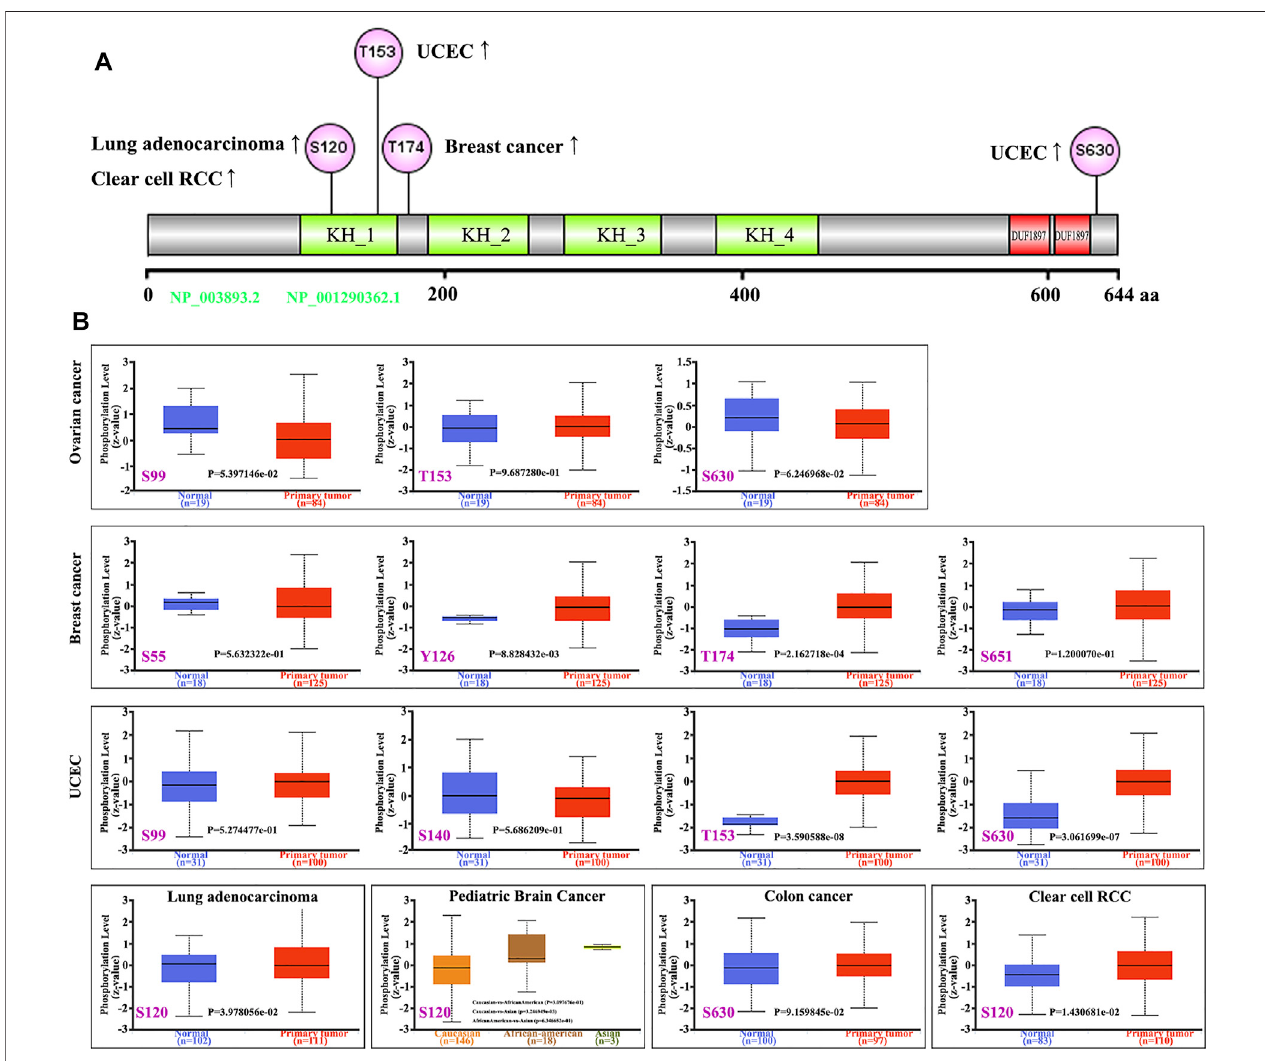
FIGURE 5 | Phosphorylation analysis of the FUBP1 protein in different cancer types. (A) The prominent phosphorylation sites are displayed in the structural schematic diagram of the FUBP1 protein. (B) The expression level of phosphorylated FUBP1 between primary tumor tissues and corresponding normal tissues was analyzed using CPTAC analysis in UALCAN, and box plots for ovarian cancer, breast cancer, UCEC, lung adenocarcinoma, pediatric brain cancer, colon cancer, and clear cell RCC are displayed.